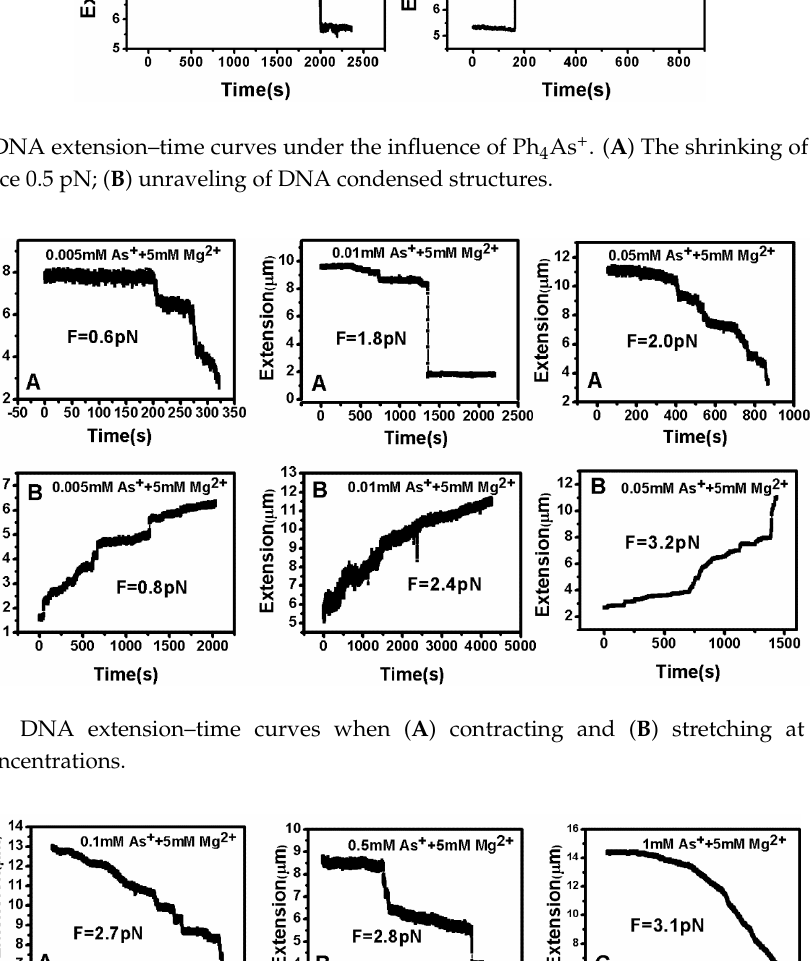
Figure 7. DNA extension–time curves at high concentrations (( A ) 0.1 mM; ( B ) 0.5 mM; ( C ) 1 mM) of Ph 4 As + .